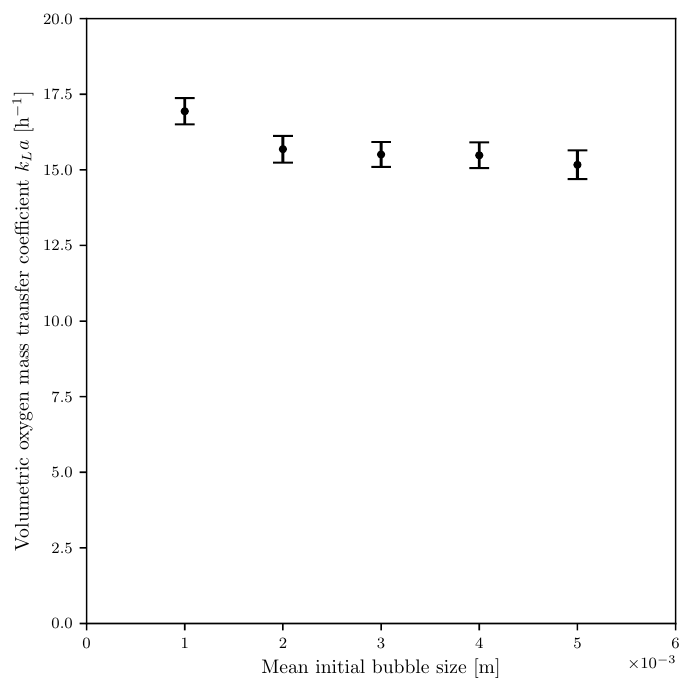
Figure A1. Influence of initial bubble diameter on the computed k L a value with the PBM coupled Euler–Euler